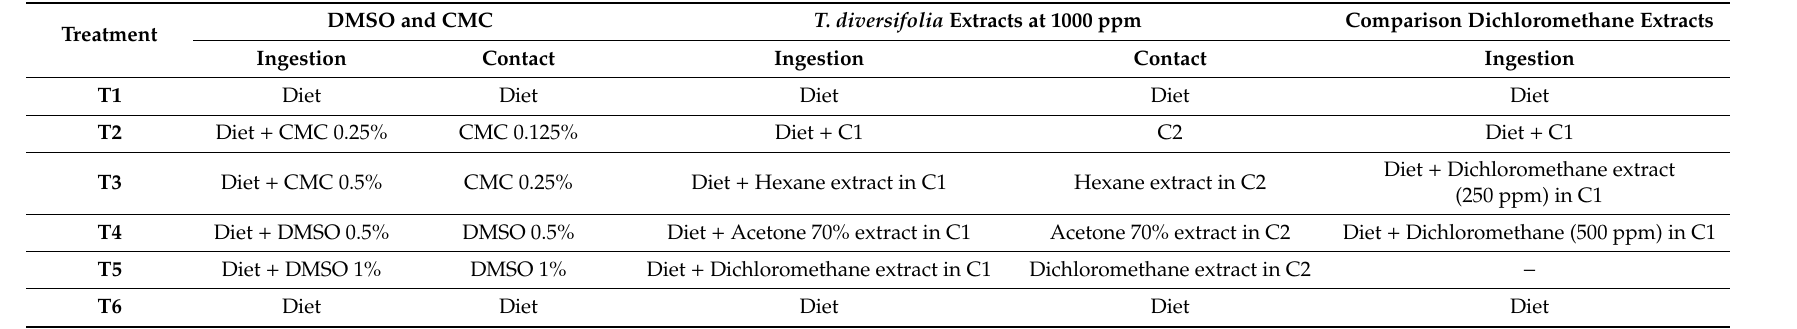
Table 1. Experimental design used in the bioassays with Atta